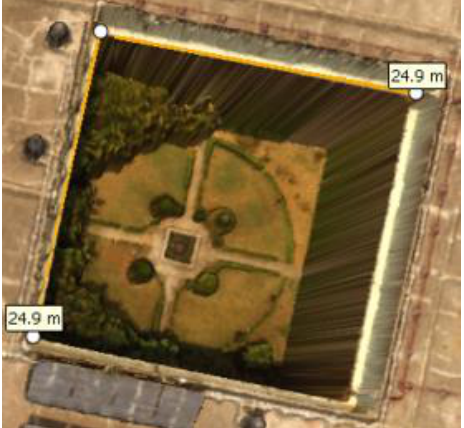
Figure.8. Dimension measurement for area